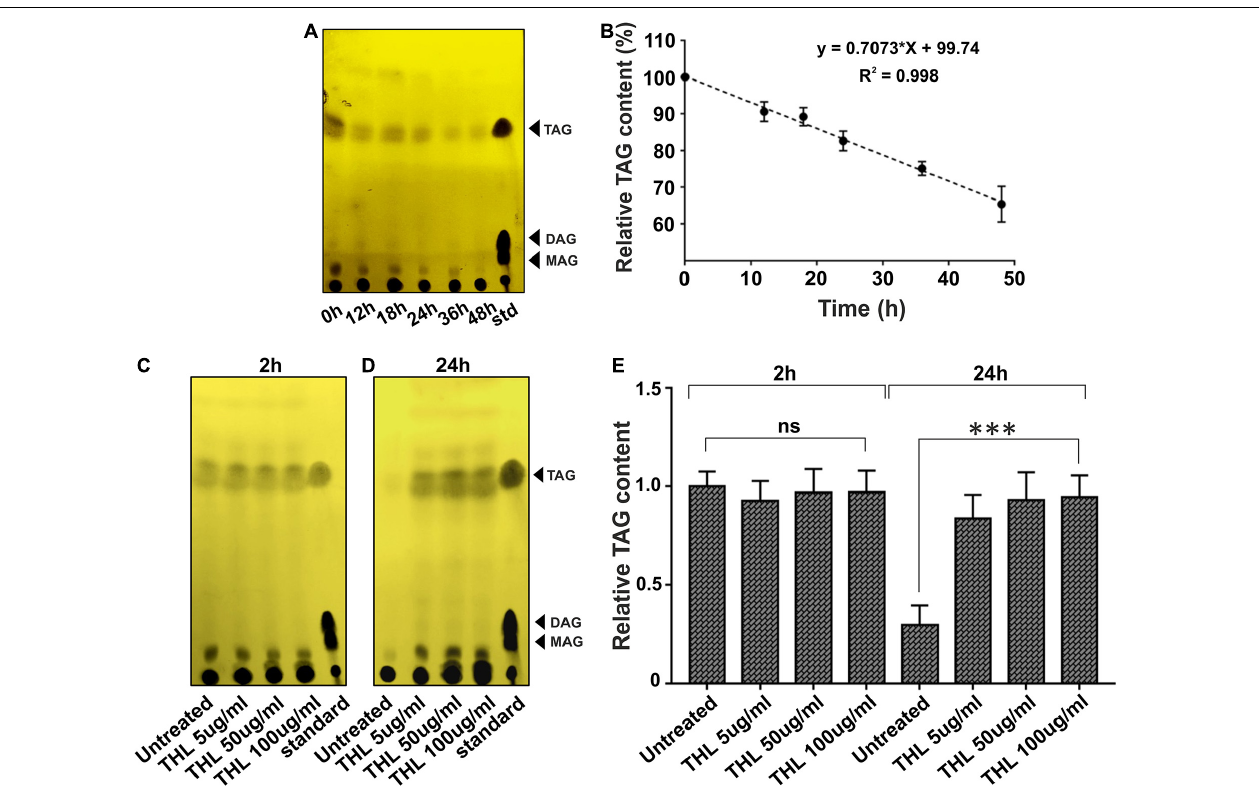
FIGURE 7 | Intracellular lipolytic enzymes mediate TAG hydrolysis in M. smegmatis (cid:49) atpD . Panel (A) shows the TLC image for the triacylglycerol (TAG) accumulation and its disappearance in M. smegmatis (cid:49) atpD upon starvation with time (in hours). TAG mobility was compared with standard (std). Spot corresponding to the TAG, diacylglycerol (DAG), and monoacylglycerol (MAG) is marked with an arrowhead. Panel (B) shows the relative quantification of TAG by densitometric analysis of the TLC with time (in hours). Here, 100% corresponds to the 0 h time point. Panels (C,D) depict the TLC image showing the TAG accumulation and disappearance after the treatment of cells with a lipase inhibitor tetrahydrolipstatin (THL) at 2 h (C) and 24 h (D) time period. “Untreated” represents cells without THL treatment. “standard” is similar to “std” in panel (A) . Panel (E) shows the relative TAG content as assessed by densitometric analysis of the TLC image, obtained before and after treating the cells with the increasing concentration of THL. The experiments were repeated at least thrice. In panels (A,C,D) , only one representative image is shown. In panels (B,E) , error bars represent standard deviation. ∗∗∗ P -value < 0.005; “ns,” not